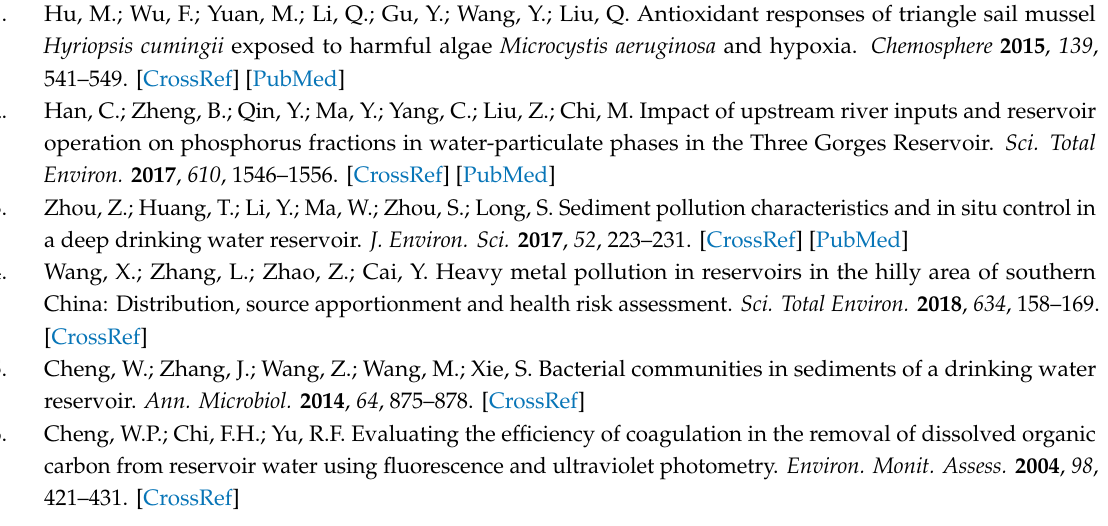
Figure S1: Vertical distribution of water temperature during the running of water lifting aeration system (9.28 means 28 September; 10.1 means 1 October); Figure S2. Vertical distribution of dissolved oxygen during the running of water lifting aeration system; Figure S3. Distribution of main phyla in enhanced areas during the operation of water lifting aeraters (The vertical axis represents the percentage of di ff erent bacteria; X-Y-Z, area-period-location; X = C and E mean control and enhanced area; Y = 1, 2, 3, 4, mean 2018-09-28, 2018-10-15, 2018-10-29, 2018-11-28; Z = S, M, B, mean surface, medium and bottom water layer); Figure S4. Changes in Proteobacteria in the enhanced area during operation of the water-lift aeration system. (The labeling is consistent with Figure